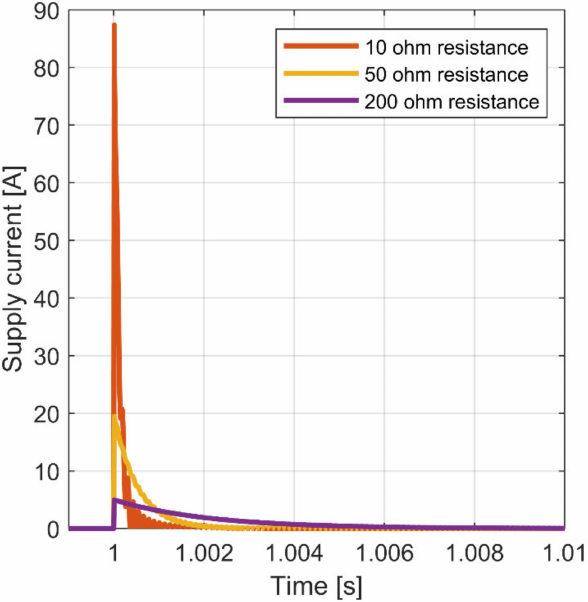
Figure 8. Electrical current in the piezo-stack actuator circuit, 0–1000 V step input for different resistance